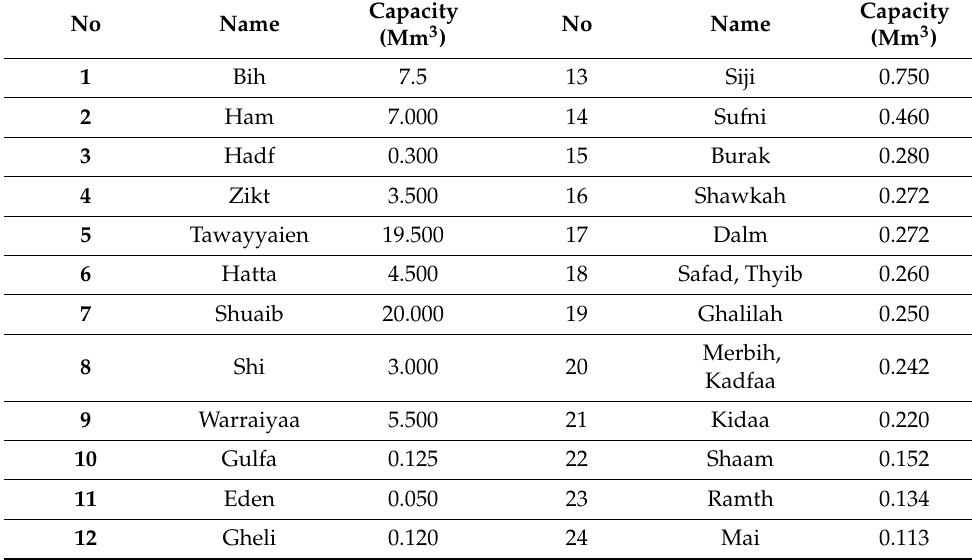
Table 12. Main dams constructed in the